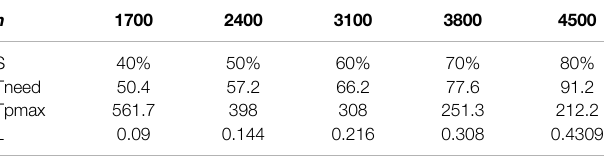
TABLE 3 | Relationship between speed n and torque load factor L.